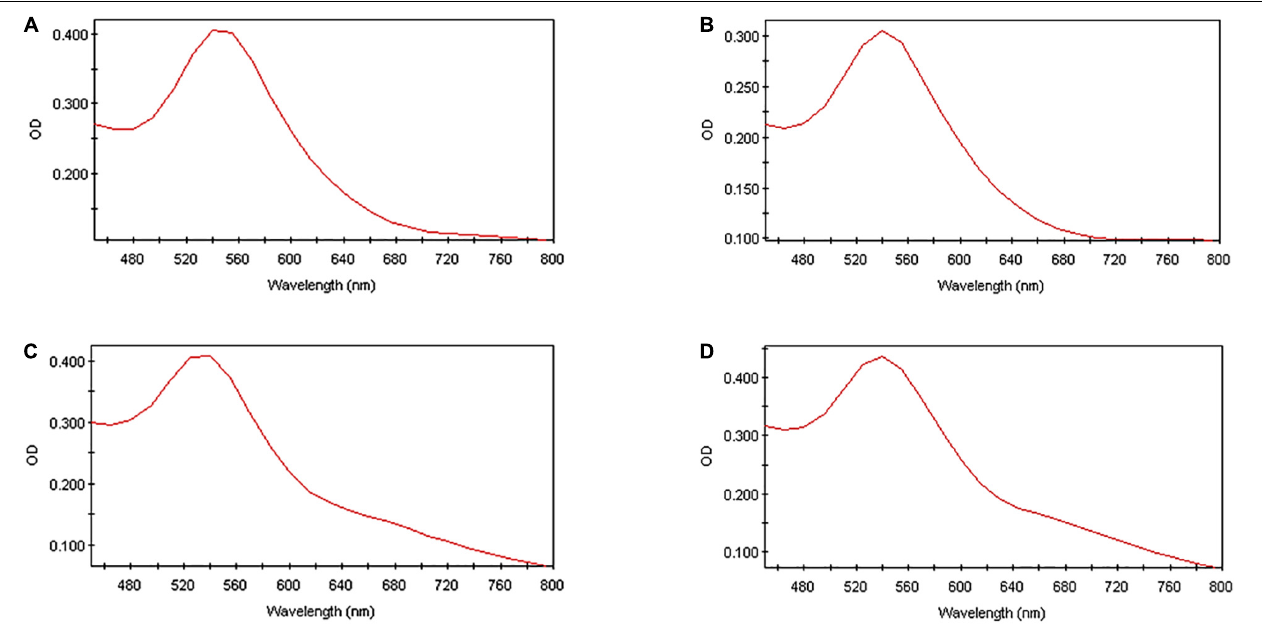
FIGURE 1 | The ultraviolet spectra of (A) Helichrysum odoratissimum methanol extract + Gum arabic, (B) H. odoratissimum methanol extract – Gum arabic, (C) H. odoratissimum leaf powder + Gum arabic and (D) H. odoratissimum leaf powder – Gum arabic gold nanoparticles after synthesis (Day 0) from 450 to 800 nm.